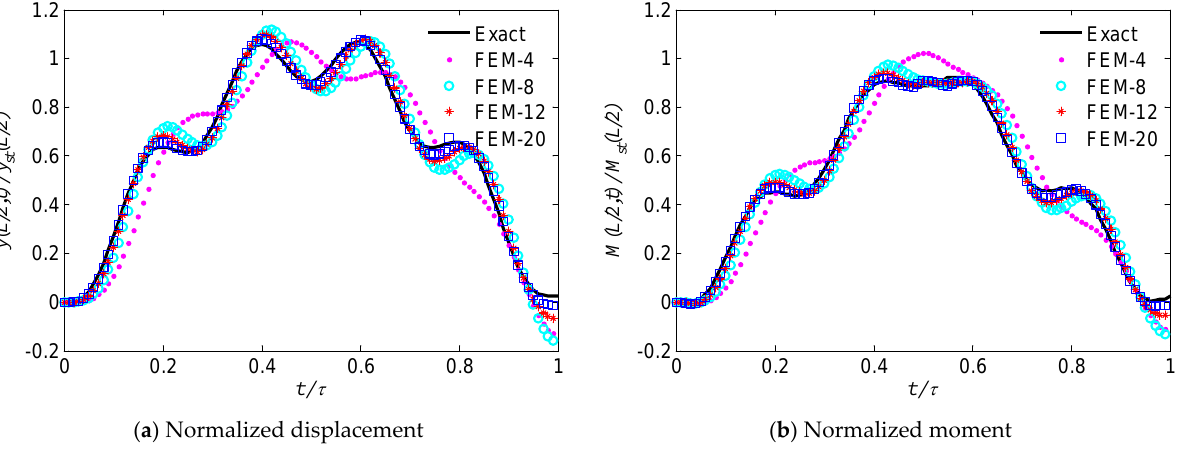
Figure 4. Numerical solutions with different element numbers of the beam with b = 0.03 and c = 0.11.